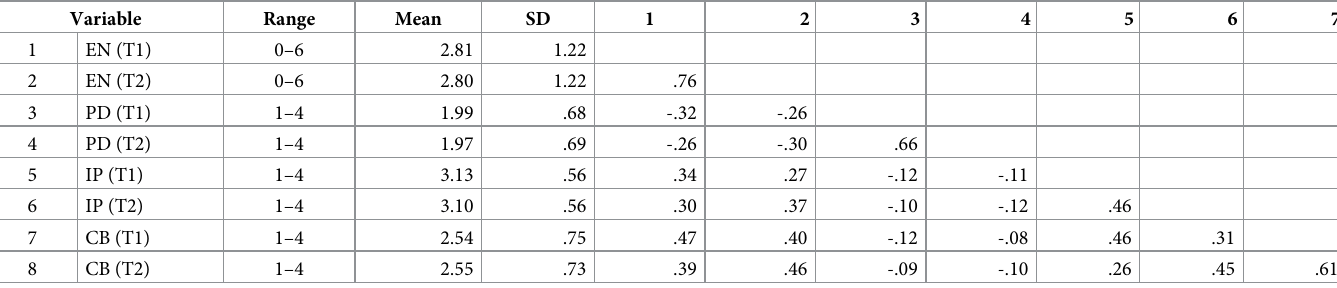
Table 1. Means, standard deviations, and correlations between the variables (N = 1,967).